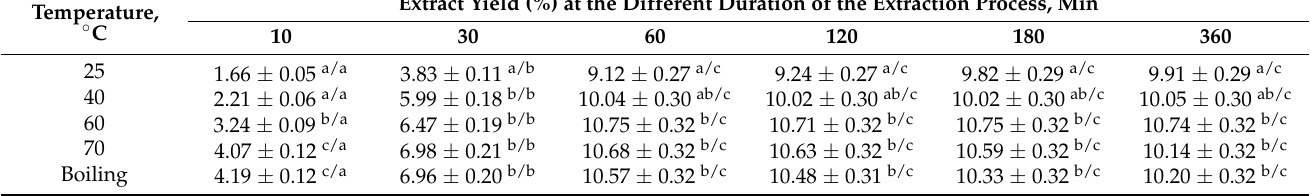
Table 2. Dependence of the Dactylorhiza maculata extract yield on temperature for different durations of the process (hydro module